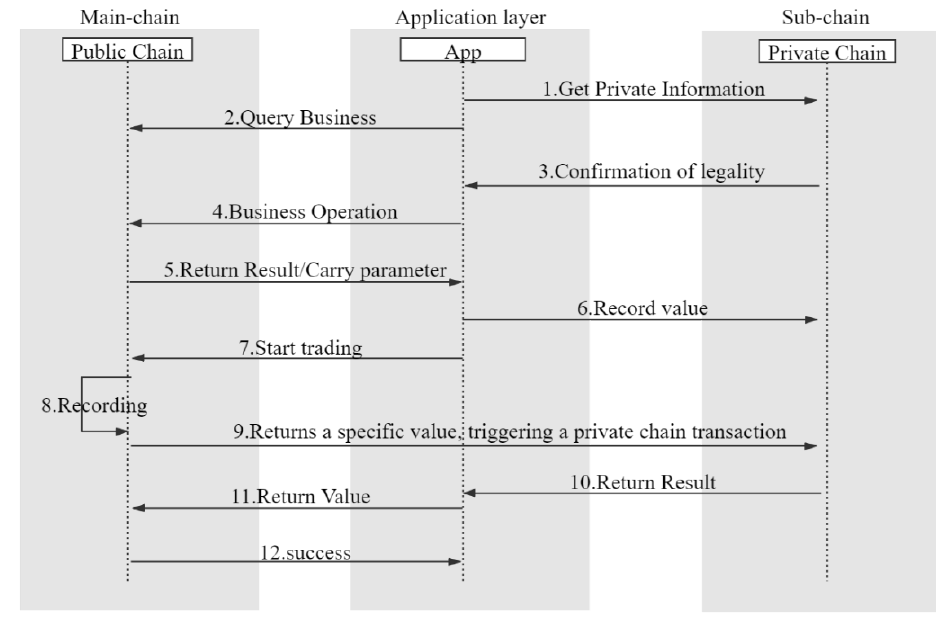
Figure 6. Service execution process in the multi-chain.